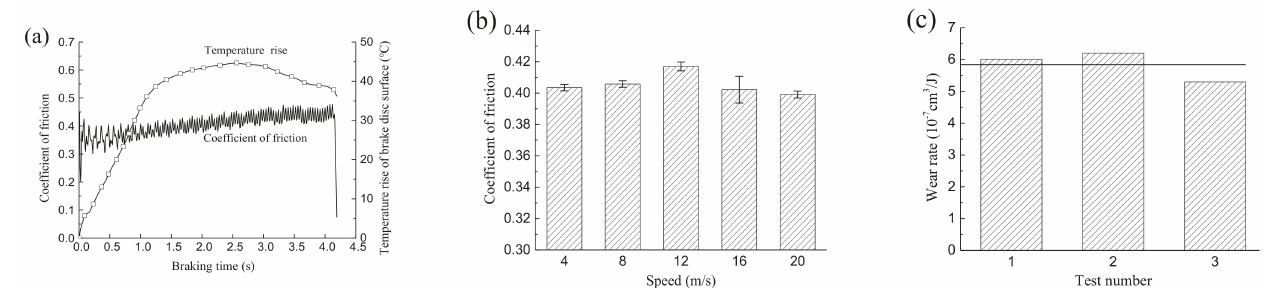
Figure 2. Tribological characteristics of brake shoe during emergency braking; ( a ) coefficient of friction and temperature rise of the brake disc surface; ( b ) average coefficients of friction during the emergency braking at distinct speeds; ( c ) wear rate of brake shoe (the solid line indicating the average value of three